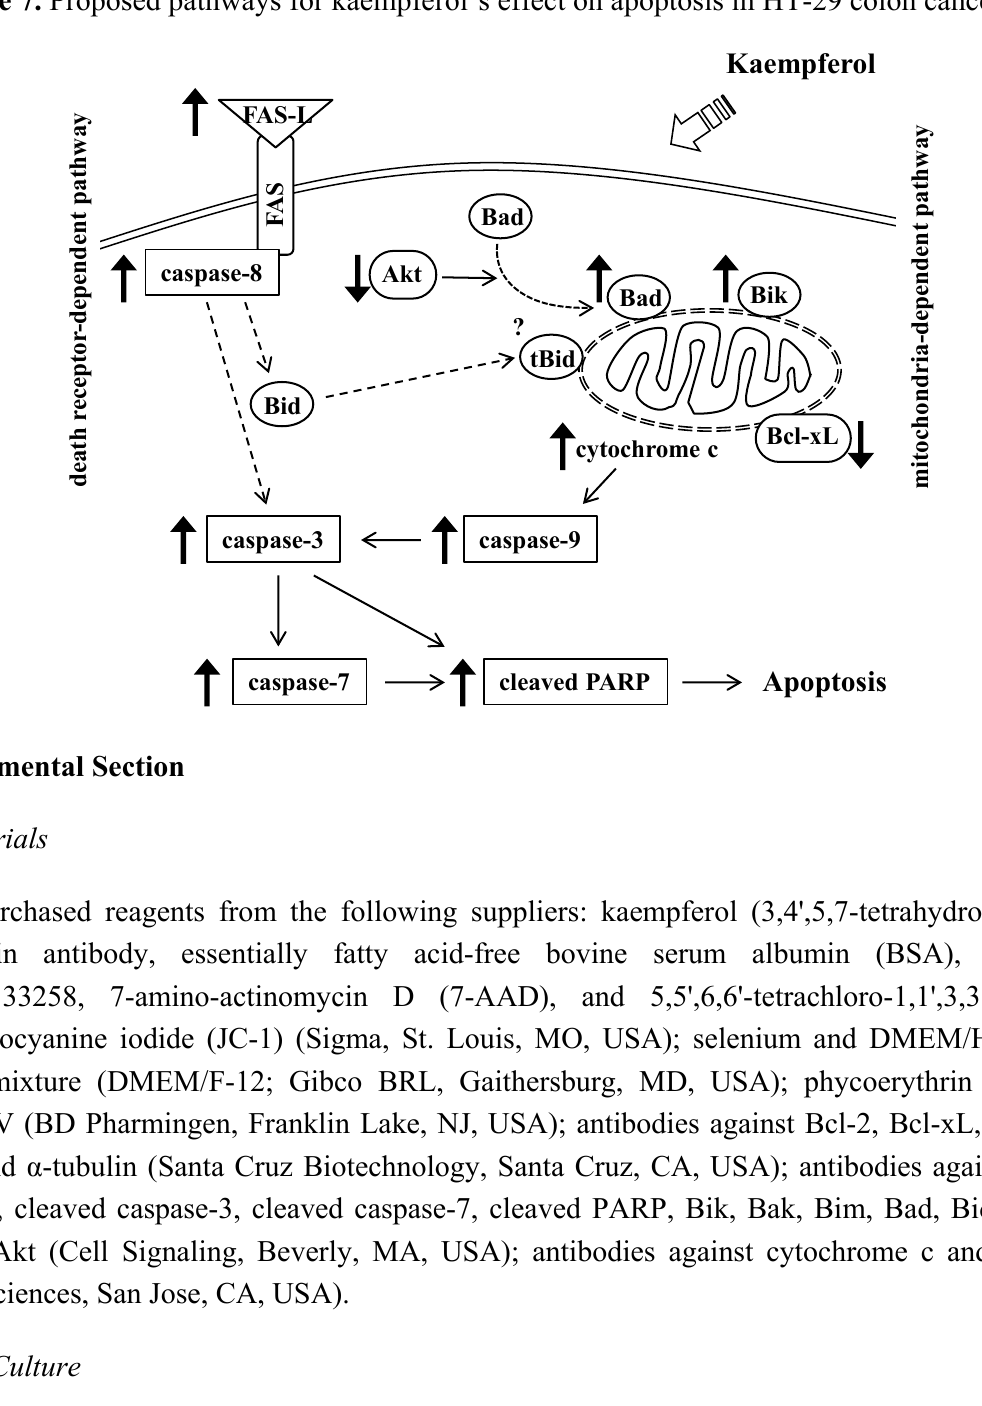
Figure 7. Proposed pathways for kaempferol’s effect on apoptosis in HT-29 colon cancer